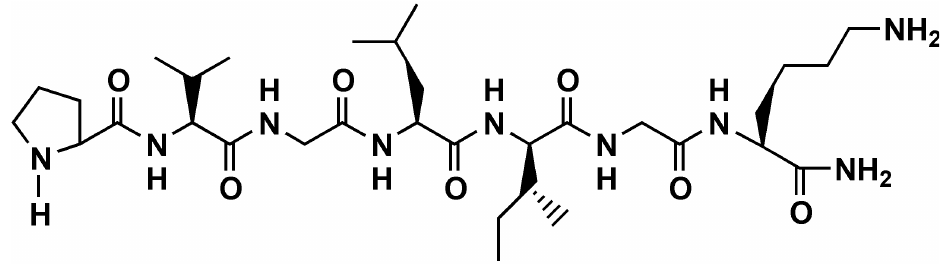
Figure 1. Structure of PVGLIGK peptide sequence.